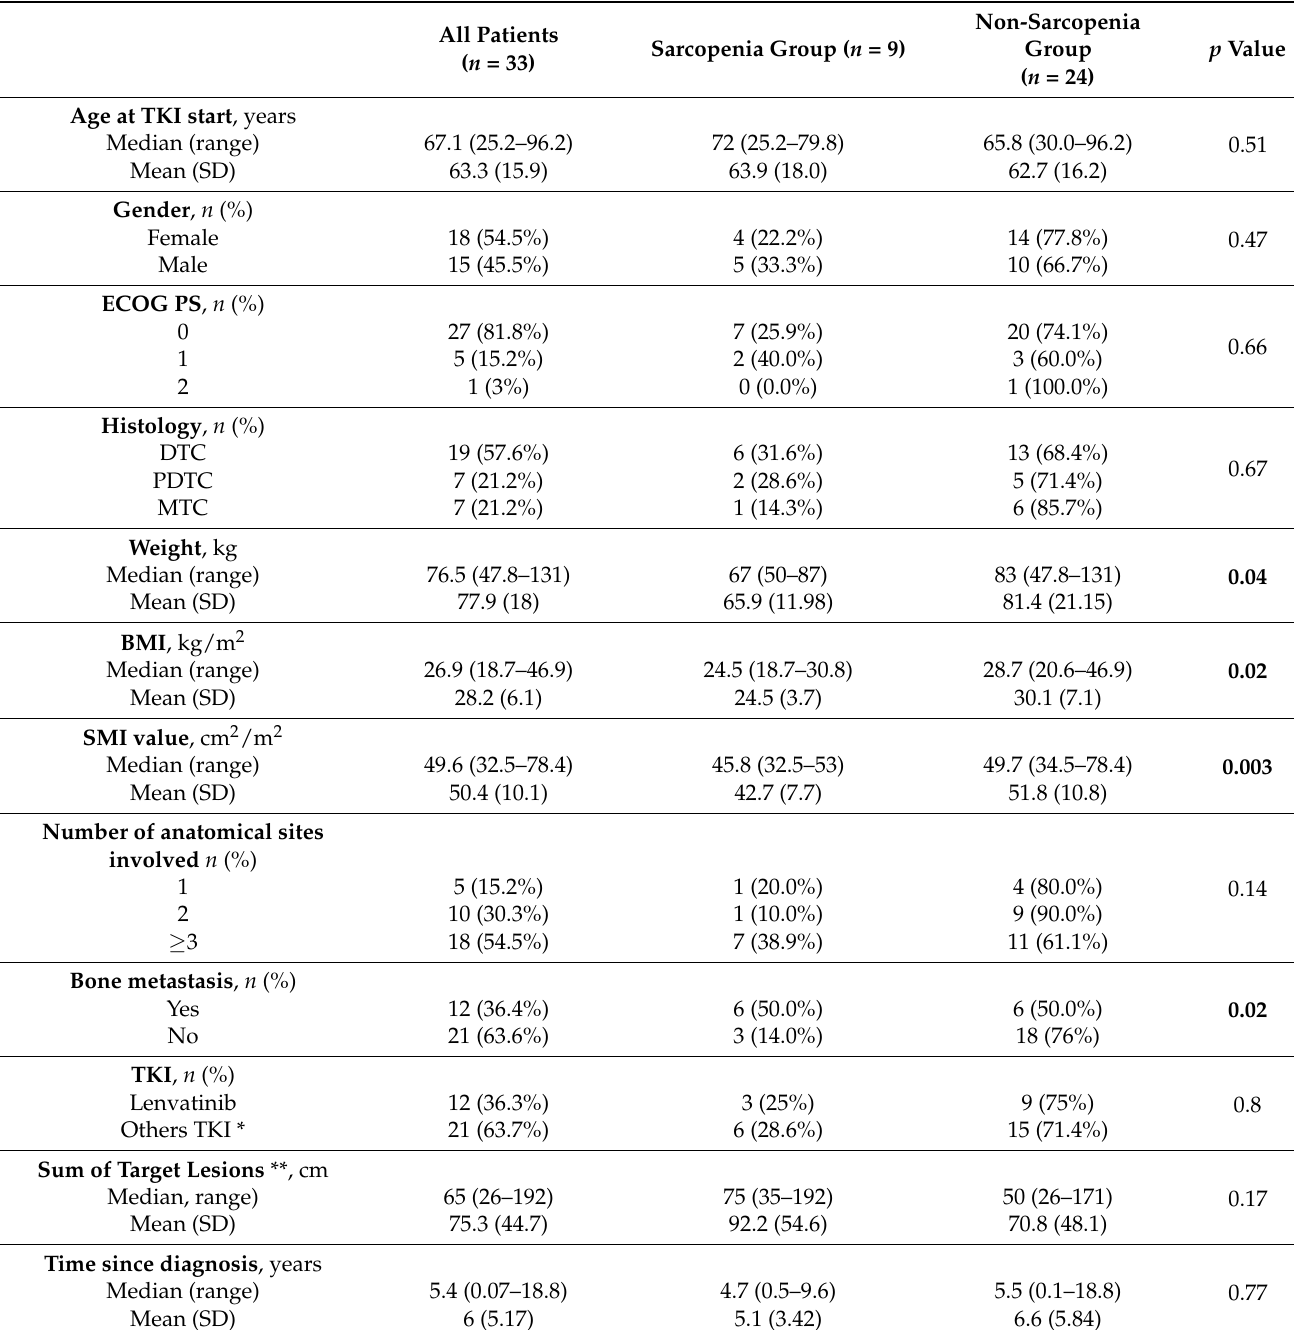
Table 3. Clinical-pathological features of 33 non-sarcopenic patients at baseline according to the development of sarcopenia after 12 months of